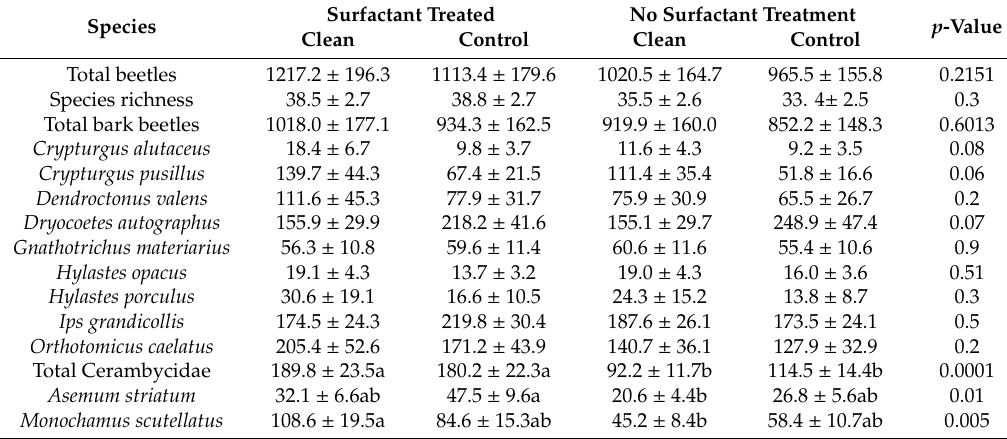
Table 1. Mean ( ± SE) total beetles, species richness, total bark beetles, total cerambycids, and individual species that accounted for ≥ 1% of total beetles captured in trap treatments during Experiment 1. Means followed by the same letter are not significantly di ff erent ( p >